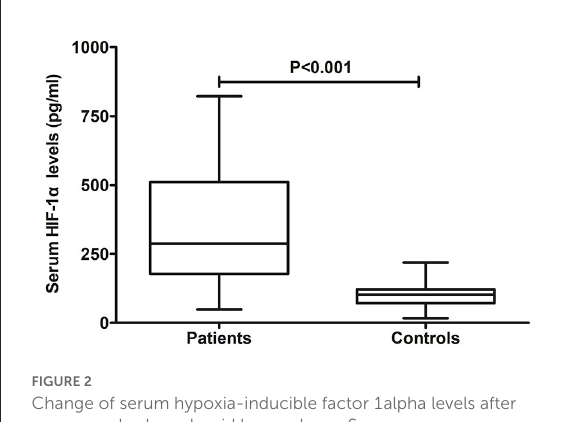
FIGURE2 Change of serum hypoxia-inducible factor 1alpha levels after aneurysmal subarachnoid hemorrhage. Serum hypoxia-inducible factor 1alpha levels were significantly elevated in comparison to healthy controls ( P < 0.001). HIF-1 α denotes hypoxia-inducible factor